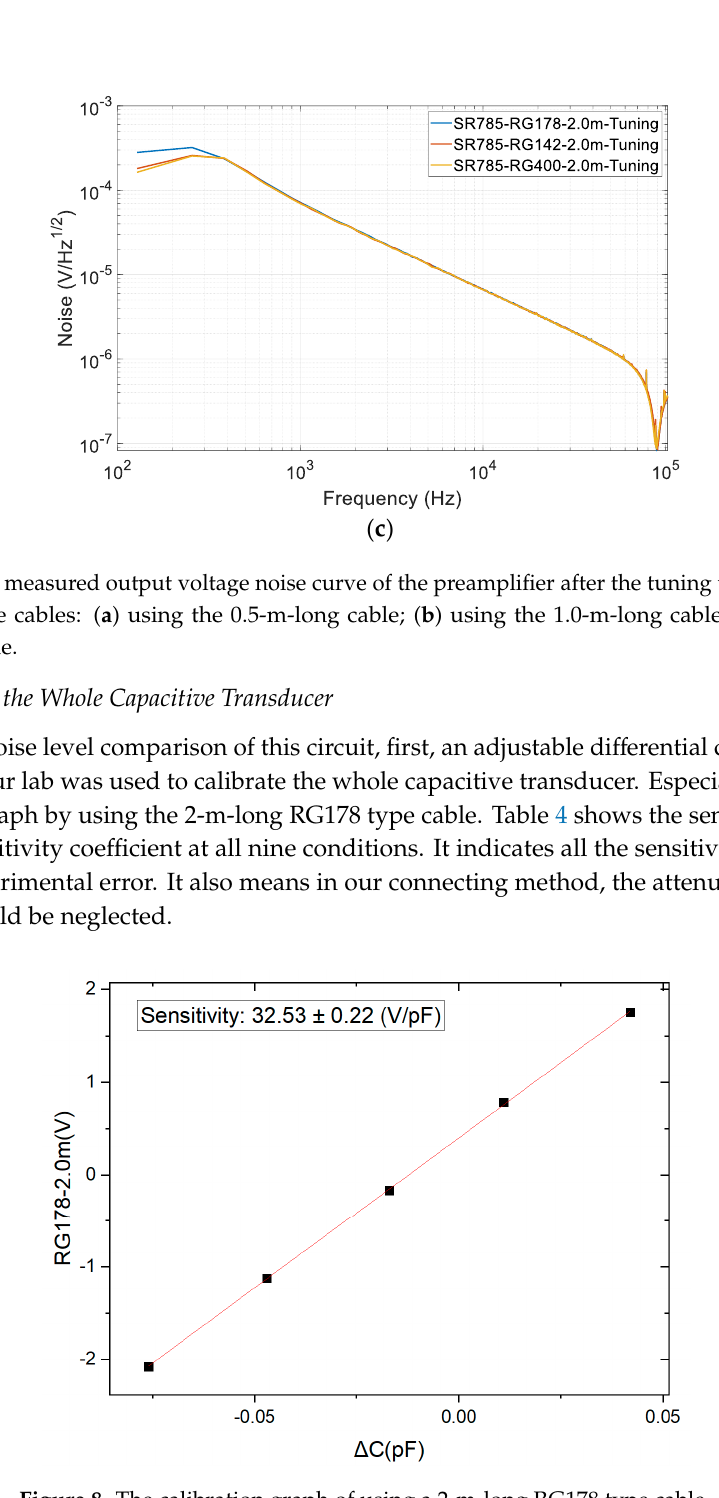
Figure 8. The calibration graph of using a 2-m-long RG178 type cable. Table 4. The sensors’ calibrated sensitivity under nine conditions.